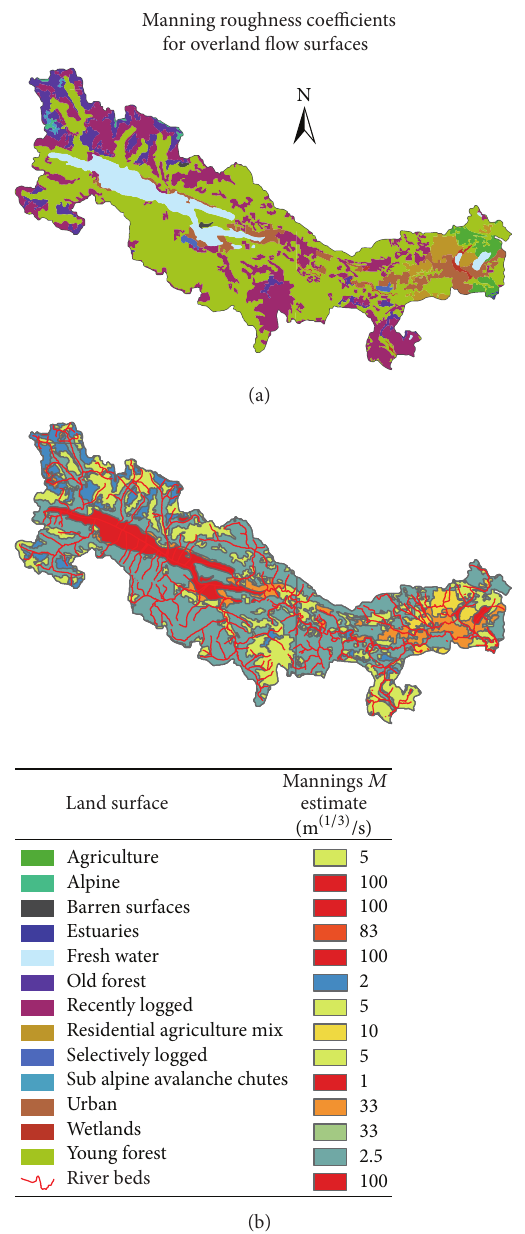
Figure 6: (a) Land surface distinctions within the Cowichan Water- shed and (b) the assigned Manning’s 𝑀 estimates for controlling overland